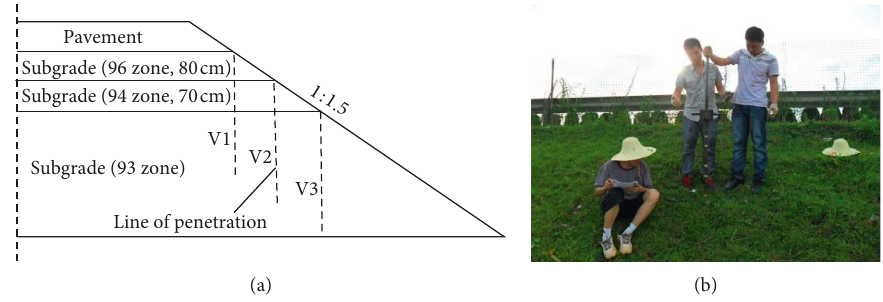
Figure 4: (a) Diagram of LDP-based test. (b) LDP-based field test.